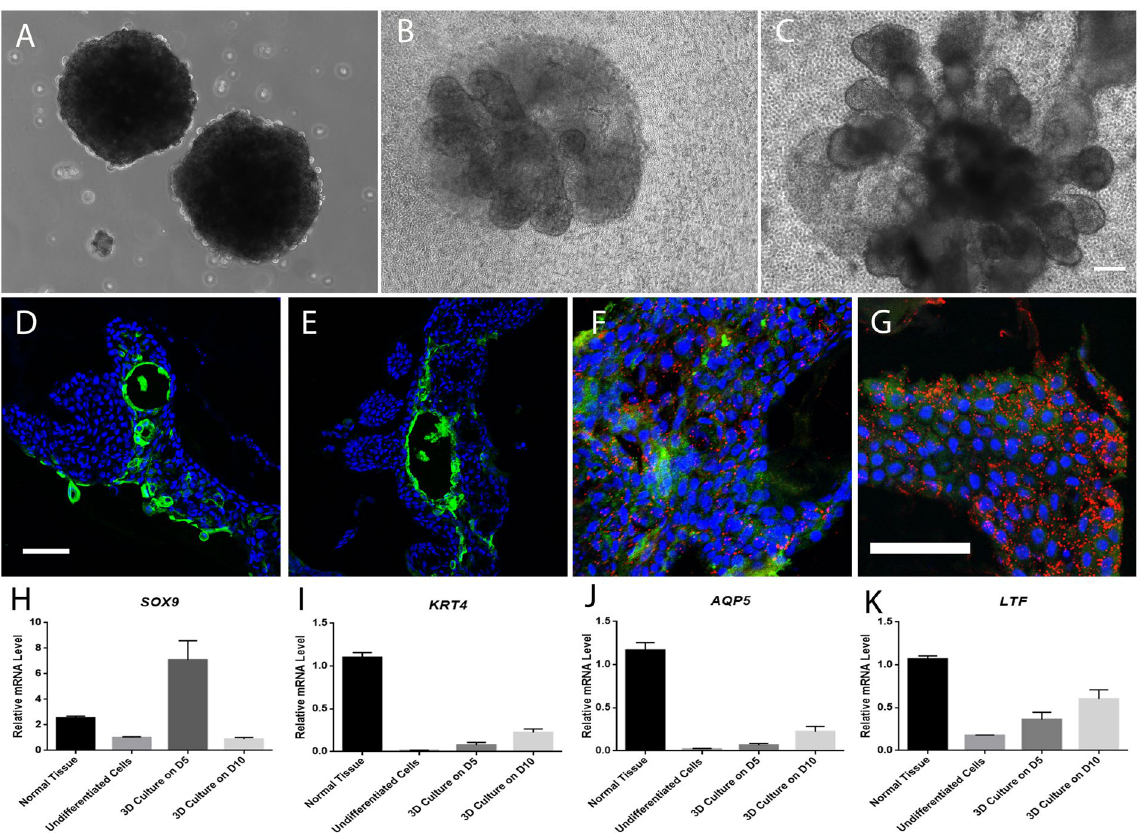
Figure 8. 3-D culture of lacrimal gland spheres. Lacrimal gland epithelial cells from day 7 post-reopening in P2 formed similarly sized lacrimal spheres in suspension culture ( A ), and gradually branched out in about 2 weeks (days in culture, 5, ( B ); 10, ( C )) to form mini gland-like structure in laminin gel. Immunostaining demonstrated K4 (green, D , E ) positive, Lactoferrin (red, F , G ) positive and AQP5 positive (green, F , G ) cells in those structures. RT-qPCR showed the mRNA level of differentiated lacrimal gland cell-related genes in the gland-like structures ( H – J ). Blue for DAPI. Bar represents 100 μ